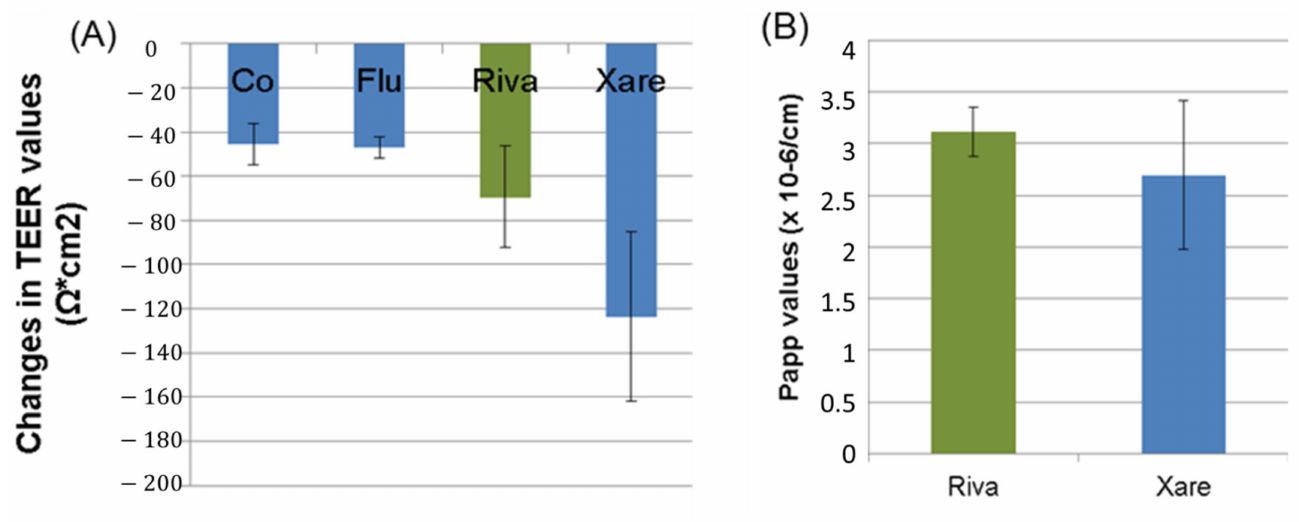
Figure 2. ( A ) Differences in transepithelial electrical resistance (TEER) values between the start value and measurement at the end of the permeation studies. Abbreviations: Control (Co), fluorescein (Flu), rivaroxaban (Riva), Xarelto (Xare). ( B ) Papp values of rivaroxaban (Riva) and Xarelto